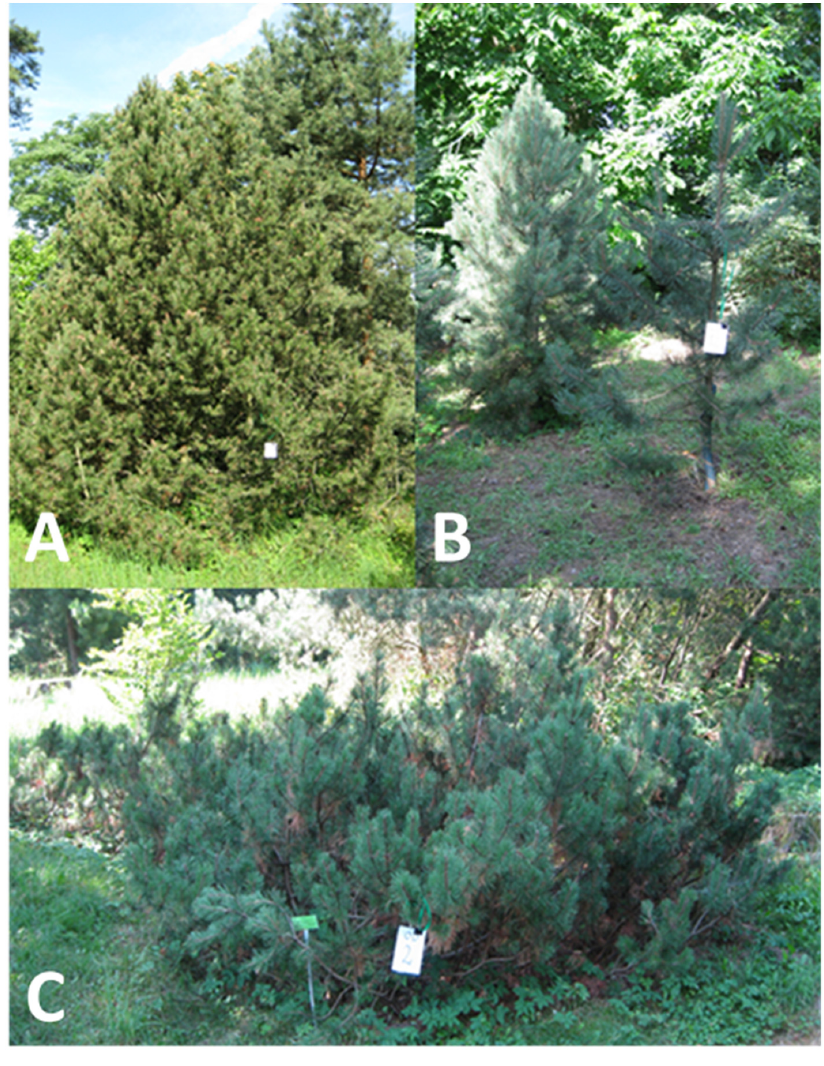
Figure 5. Morphology of the representatives of the Pinus mugo complex analyzed in this study. ( A ): Pinus × rhaetica , ( B ): Pinus uliginosa , ( C ): Pinus mugo.